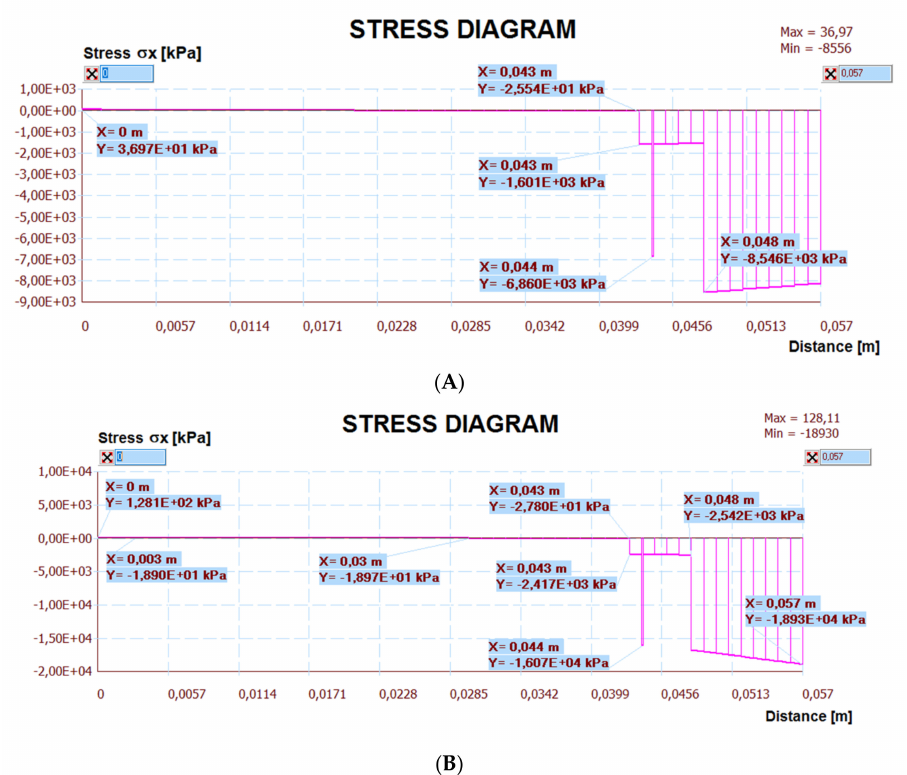
Figure 33. Diagram of horizontal stresses σ x in the III–III section: ( A ) thermal action without ceiling deflection; ( B ) thermal action and imposed load with ceiling